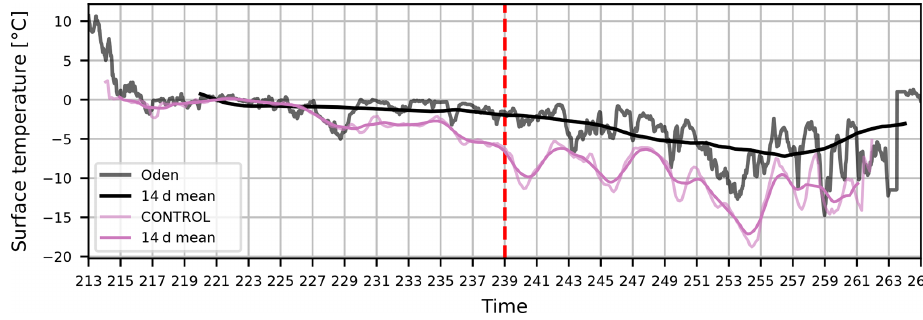
Figure A1. Time series of surface temperature during the AO2018 campaign periods from observations and simulation CONTROL. Obser- vations are shown as 30min mean values (grey line) and 14d running mean values (black line). Model output is shown as 3-hourly mean values (pale pink line) and 14d running mean values (dark pink line). The observed sea ice freeze-up point (when the 14d mean reaches − 2 ◦ C) is marked with a dashed red